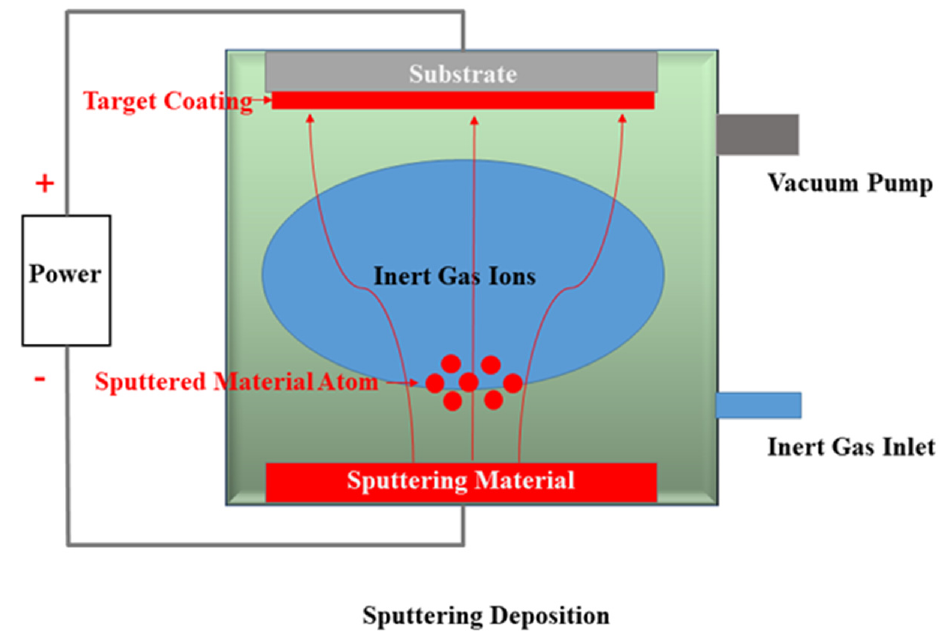
Figure 1. A schematic illustration of sputter-deposition.